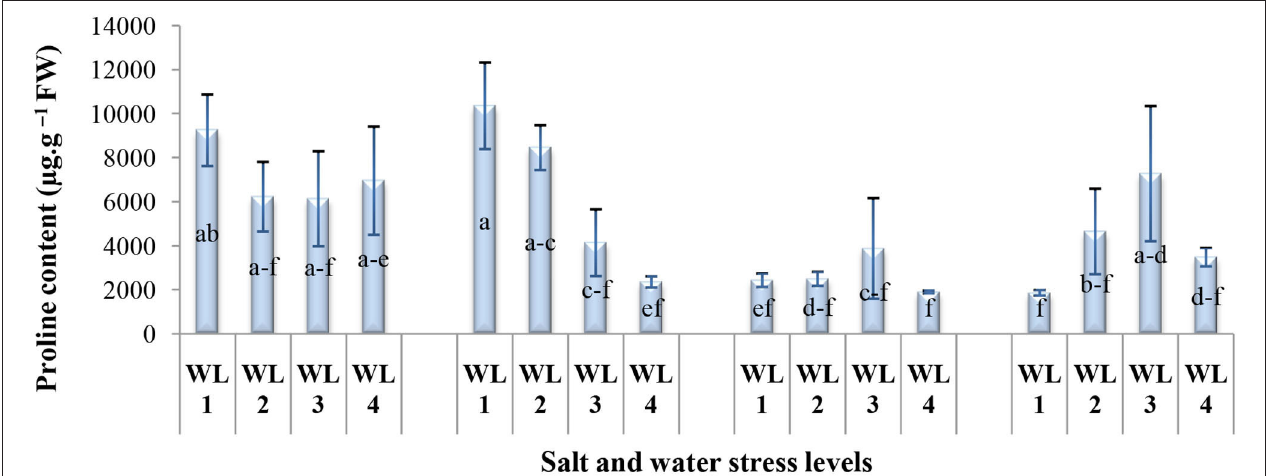
Figure 6 | Interactive effect of salinity and drought stress on the proline content ( µ g g − 1 FW) of S. imbricata . Value bars with different letters are significantly different from each other at α = 0.05, while error bar represents the standard error of mean ( n = 3). WL stands for water level (WL1 = 100% field capacity, WL2 = 80% field capacity, WL3 = 60% field capacity, and WL4 = 40% field capacity), while S represents salinity (S1 = 5 dS m − 1 , S2 = 10 dS m − 1 , S3 = 15 dS m − 1 , and S4 = 20 dS m − 1